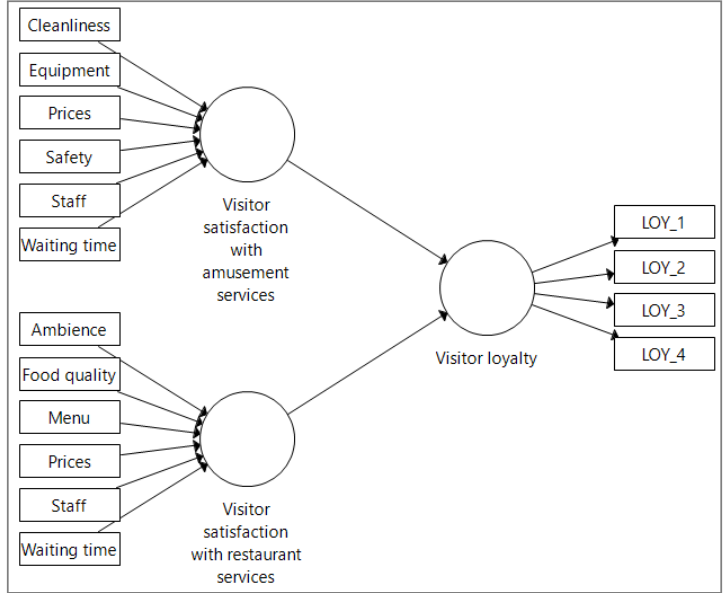
Figure 1. Proposed path model for the impact of visitor satisfaction on visitor loyalty.